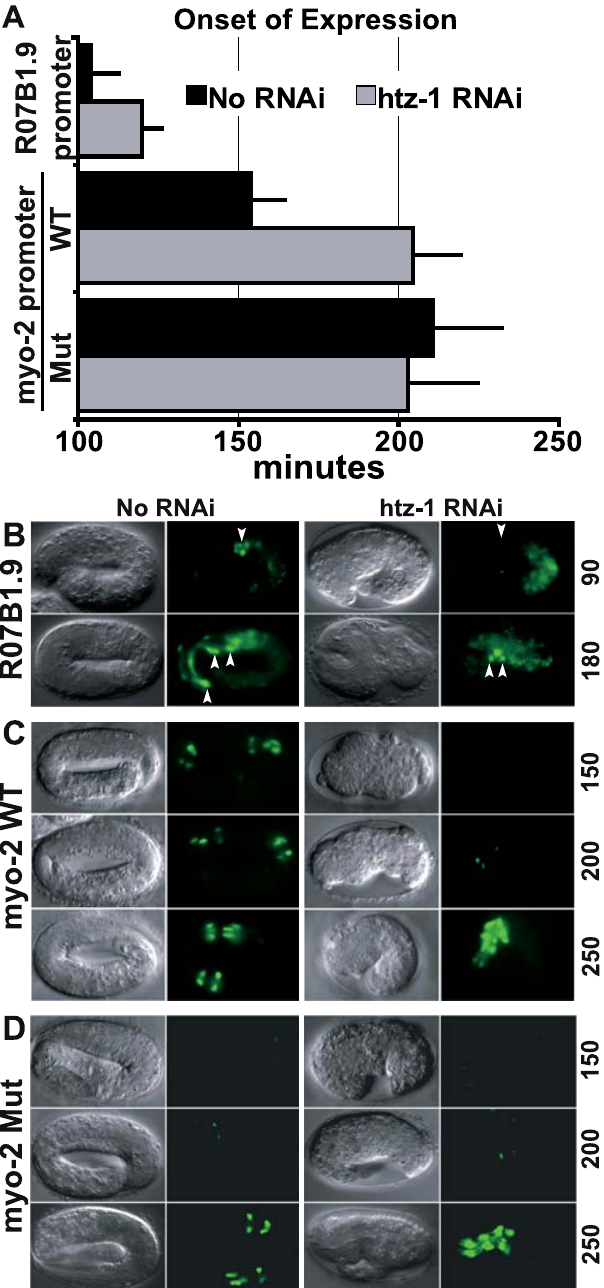
Figure 7. htz-1 Influences the Onset of Late Pharyngeal Gene Expression (A) Onset of R07B1.9::GFP and myo-2:: GFP after the comma stage for wild- type (black) or htz-1(RNAi) (grey) embryos. Activation of the R07B1.9 reporter was delayed after injection of htz-1 dsRNA ( p , 0.0001, Student t -test). No RNAi: n ¼ 18, htz-1 RNAi: n ¼ 12 embryos. myo-2 activation was scored in embryos carrying either a wild-type myo-2 ::GFP reporter (WT) or a myo-2:: GFP reporter with both PHA-4 binding sites mutated (Mut) [18]. Activation of the WT reporter was delayed after injection of htz-1 dsRNA ( p , 0.0001, Student t -test), whereas onset of the Mut reporter was unchanged ( p ¼ 0.2068). No RNAi: n ¼ 15 WT, n ¼ 33 Mut Embryos; htz-1 RNAi: n ¼ 9 WT, n ¼ 21 Mut embryos. Error bars indicate the standard deviation. (B) Expression of R07B1.9::GFP at 90 and 180 min after the comma stage with htz-1 RNAi or without (No RNAi). Pharyngeal R07B1.9::GFP is indicated by arrowheads. (C) Expression of myo-2 ::GFP (WT) at 150, 200, and 250 min after the comma stage with htz-1 RNAi or without (No RNAi).